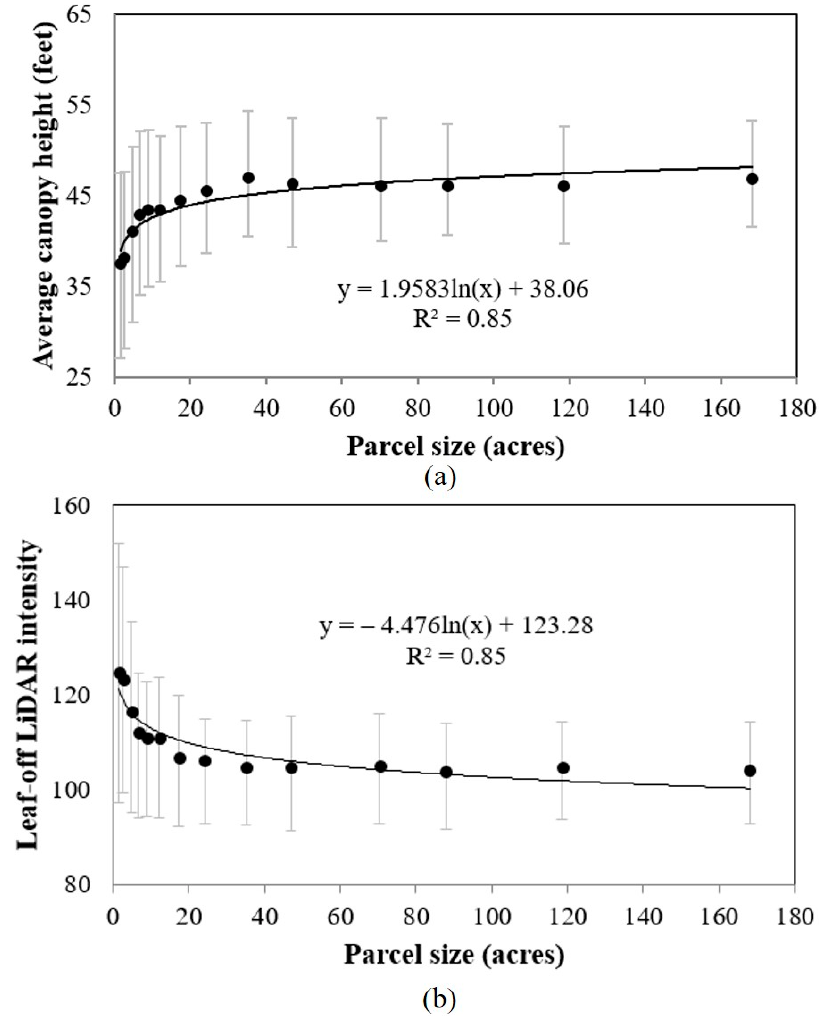
Figure 13. LiDAR Canopy height versus parcel size ( a ) and LiDAR intensity versus parcel size; ( b ). The black point is mean value of each bin, the error bar is the 0.25–0.75 percentiles, and the solid line is the regression line.